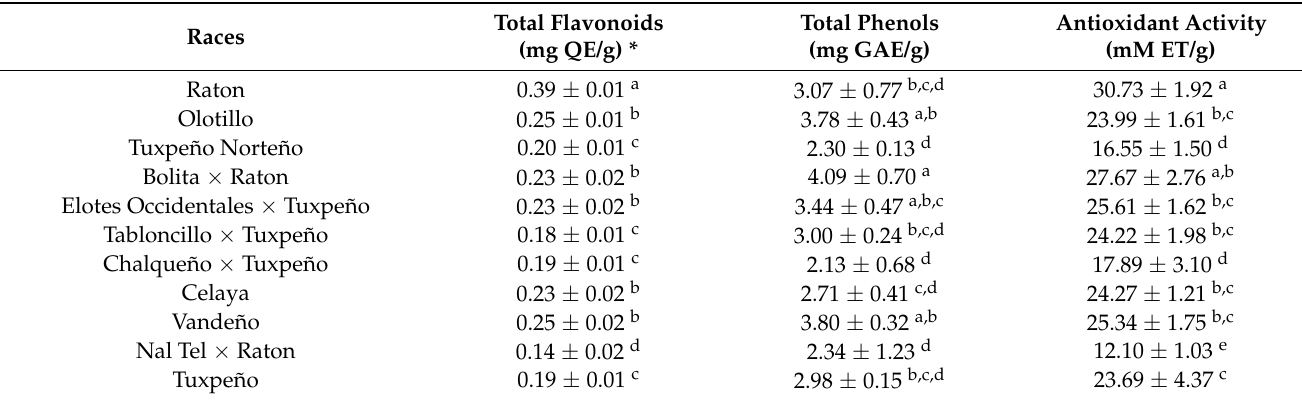
Table 2. Total phenols concentration (TPC), total flavonoids concentration (TFC), and antioxidant capacity in the leaf of different races of